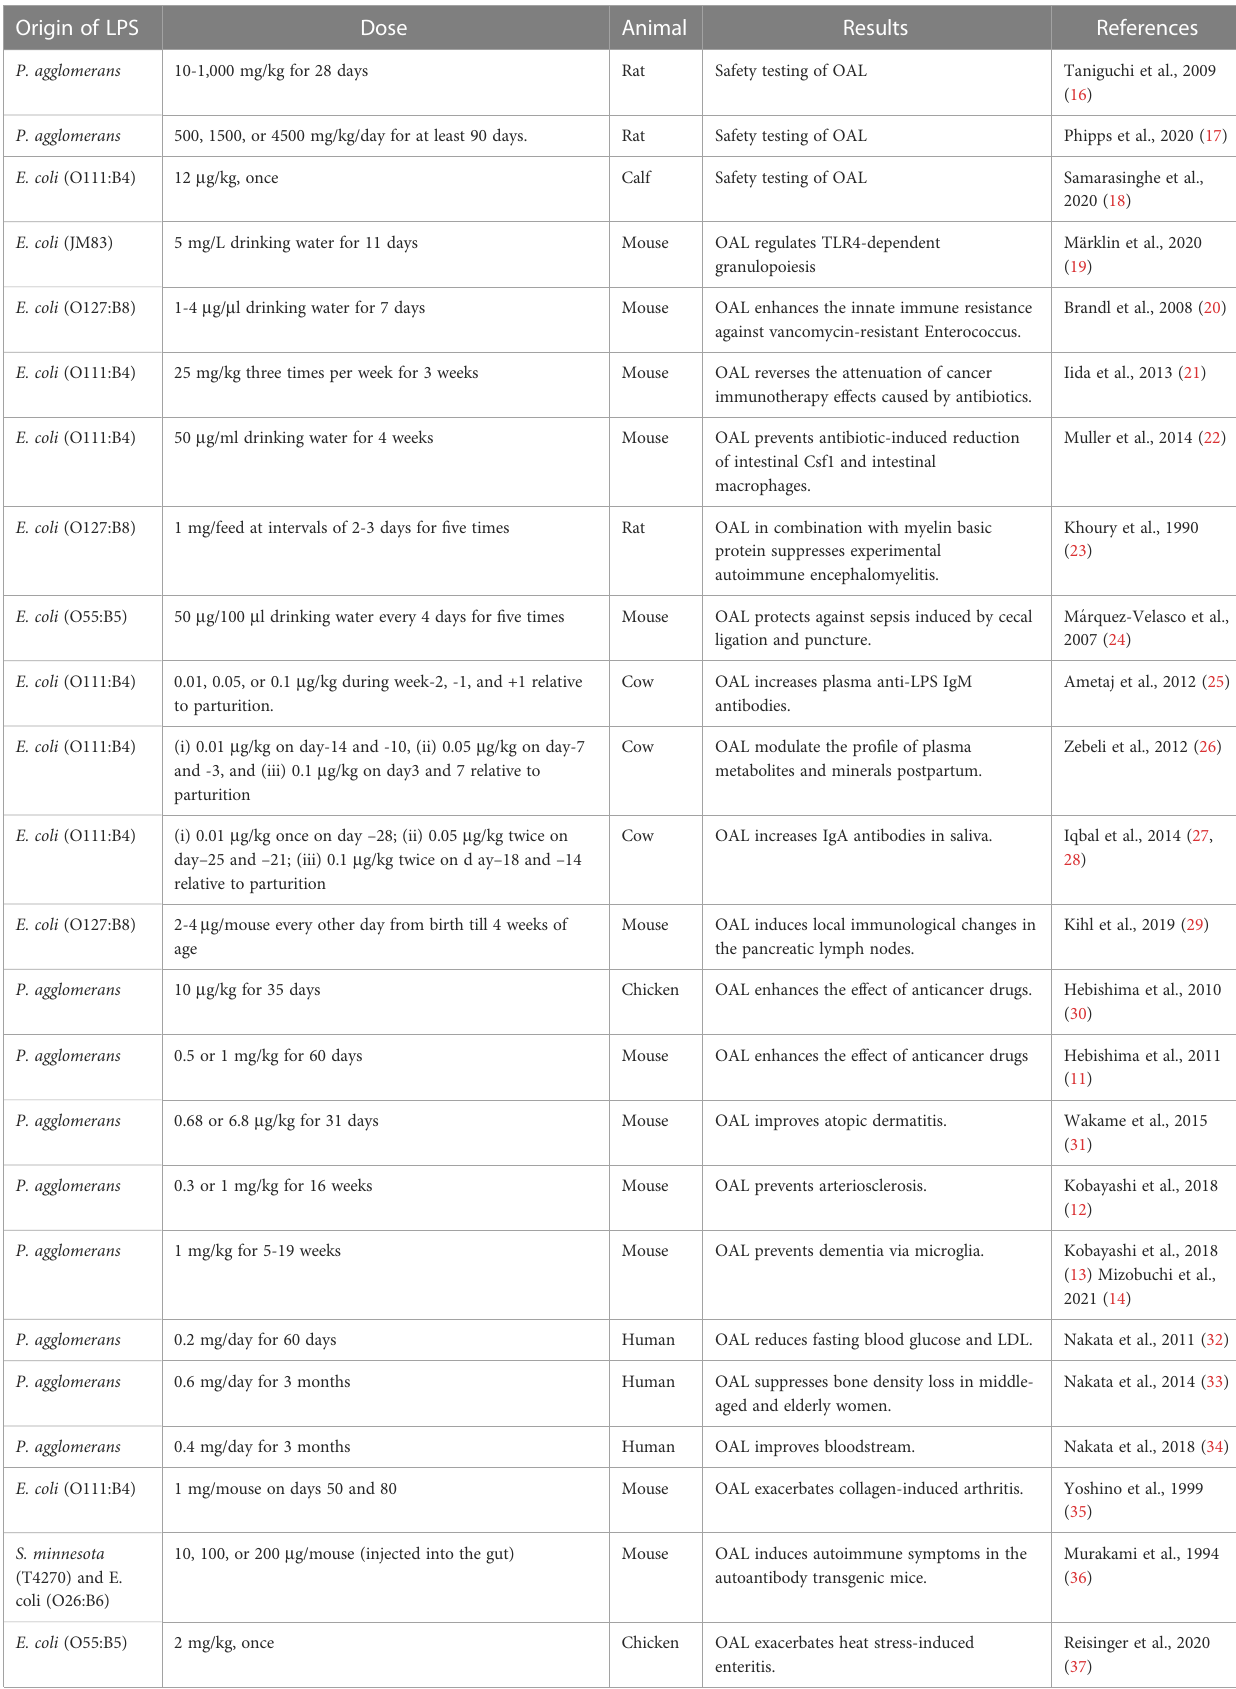
TABLE 1 Studies on oral administration of